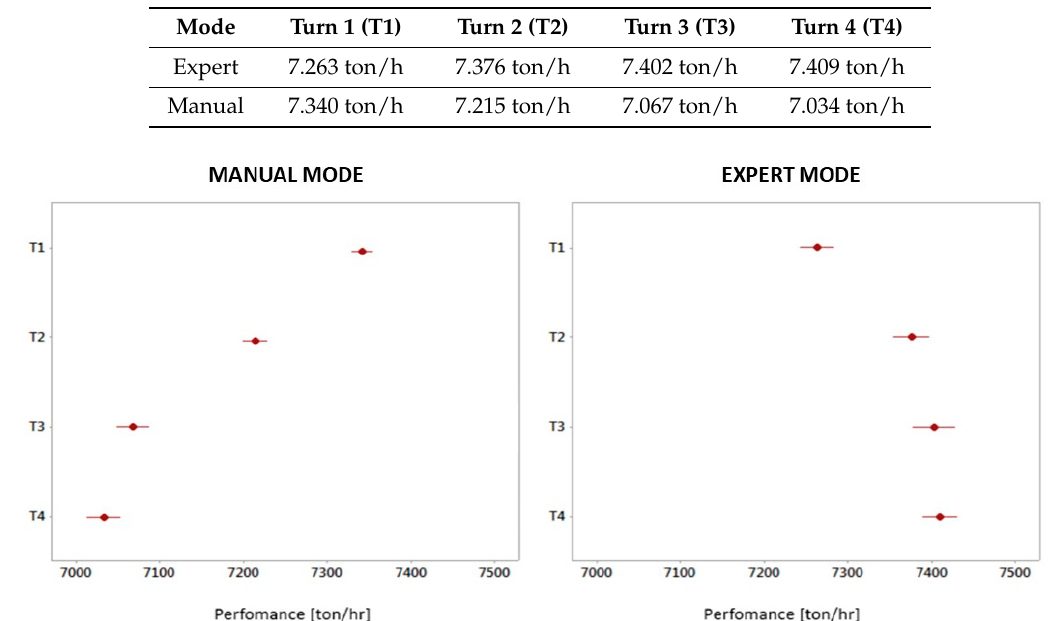
Figure 4. Anova hypothesis test, yields by turns in both modalities.